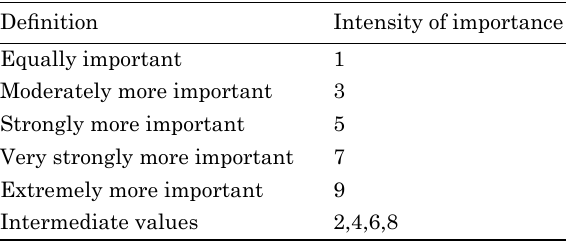
Table 2. nine-point intensity of importance scale and its description